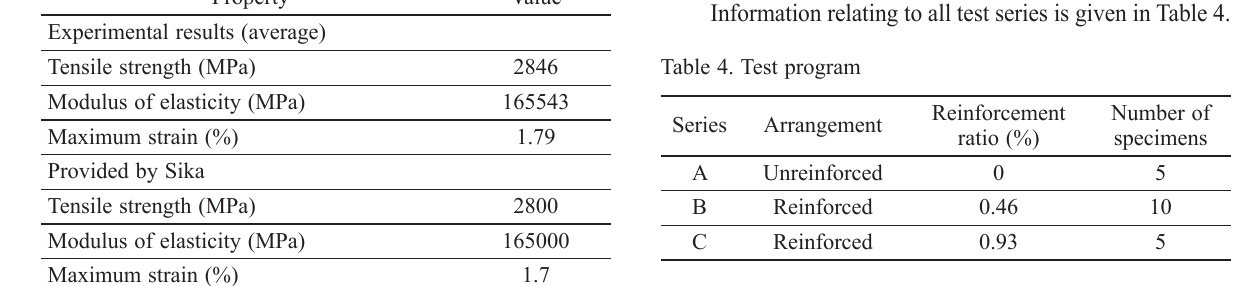
Table 2. Summary of results for tensile test of CFRP plates Property